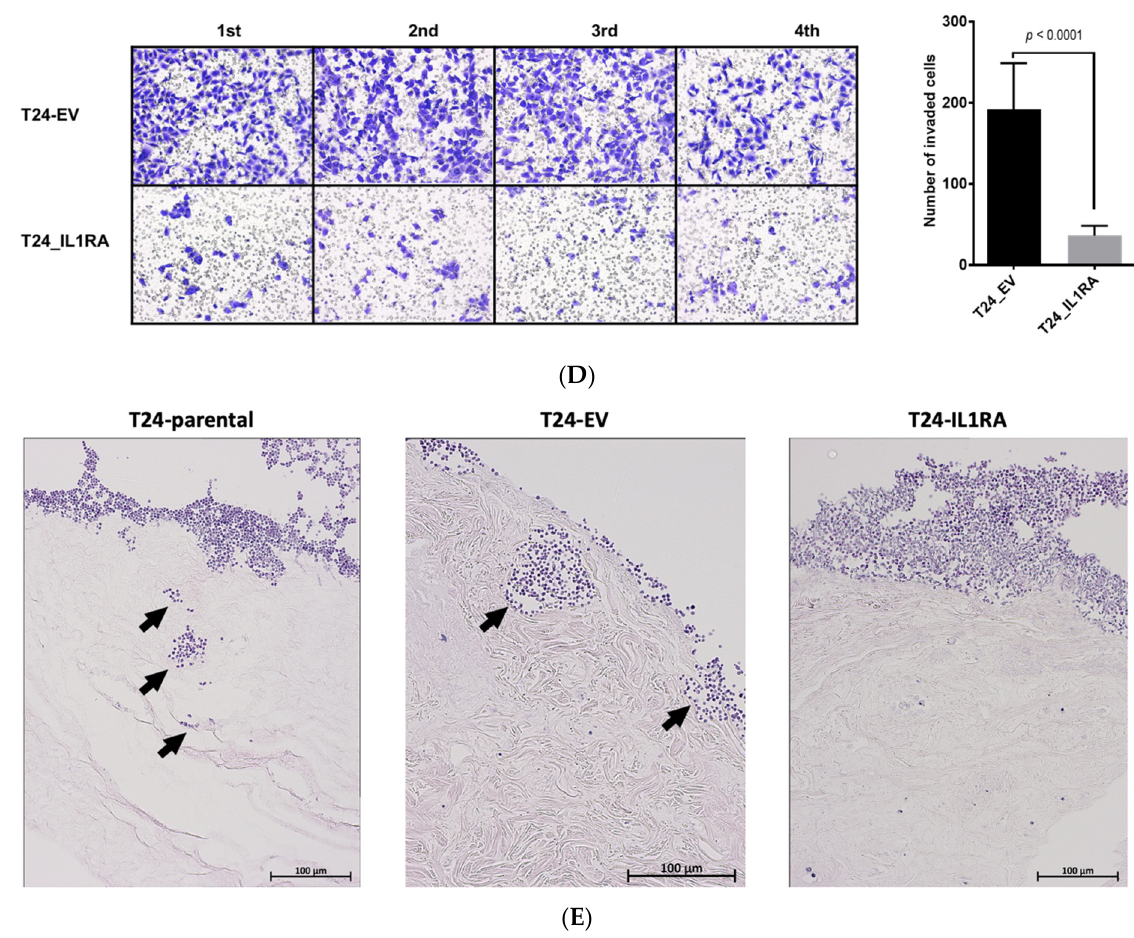
Figure 3. Ectopic IL1RA expression impairs migration and invasion capacity of invasive T24 cell line in RTCA experiments. ( A ) Ectopic IL1RN expression in invasive T24 cells. (Left) RT-qPCR showing the ectopic IL1RN expression in infected T24-IL1RA cells (T24-pBabe-IL1RN) compared to parental T24 and mock-infected empty vector T24 (T24-pBabe-Puro) (** indicates p = 0.026). IL1RN expression in RT4 cells served as a positive control. (Right) Western blot results confirmed the overexpression of IL1RA. T24-IL1RA exhibit a strong IL1RA signal, with an intensity similar to the positive control RT4 cells. T24-negative control cells (T24 parental and T24-EV) showed no signal for IL1RA. β -ACTIN served as a loading control. ( B , C ) The graphs show migration (left) and invasion (right) capacities of T24-IL1RA (T24-pBabe IL1RN) compared to T24-EV (T24-pBabe-Puro). Wells containing serum-free media (RPMI) served as control. In the migration setting ( B ), CI values of T24-IL1RA are consistently lower than those of T24 empty vector. In the invasion setting ( C ), the difference in CI clearly manifests after 30 h. The graphs show the quantification of the cell index (mean) at the 40 h time-point. The experiment was performed two times ( n = 2) in the migration setting and three times in the invasion setting, with quadruplicates of each experiment. Depicted are the mean CI ± SD calculated from quadruplicates of one experiment. ( D ) Ectopic IL1RN expression impairs migration and invasion capacity of invasive UCB cell lines as determined by the Boyden chamber assay. Four independent repeat experiments (1st, 2nd, 3rd, and 4th) were performed to determine the impact of IL1RA on cell invasion through Matrigel after an incubation period of 48 h (left). The results were evaluated quantitatively by manually counting the cells in five randomly selected membrane areas using the image processing program ImageJ (Version 1.51). The average number of invaded cells of T24-IL1RA is significantly lower compared to T24-EV (right). ( E ) Ectopic IL1RN expression impairs the invasion capacity of the T24 cells in the porcine bladder organ culture model. Representative pictures are shown indicating invasion (black arrows) of the parental T24 (left) and T24 cells containing the empty vector (middle) into the porcine lamina propria while invasion was completely absent with the T24-IL1RA cells (right). Images were taken with the microscope Axio Imager 2 (Zeiss, Oberkochen) at 200× magnification. Consistent with the RTCA results (CI dropped from 3.6 with T24-EV to 1 with T24- IL1RN cells), the overexpression of IL1RN strongly impaired the invasion of T24-IL1RA cells through a Matrigel layer in the Boyden chamber experiment (Figure 3D). Both assays